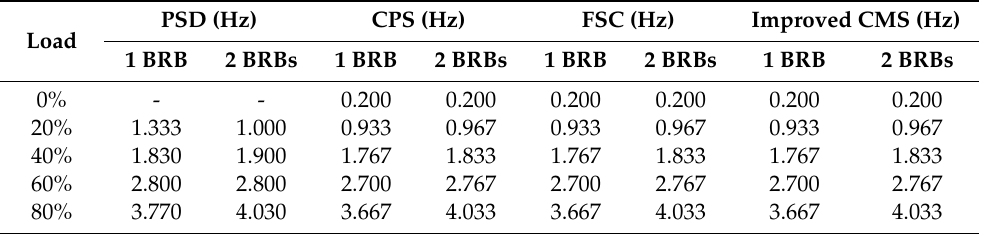
Table 6. The di ff erent characteristic frequencies detected by four methods under di ff erent loads.